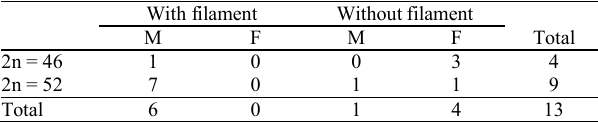
Table 3. Frequency of Pimelodella individuals with or without dorsal fin filament in relation to the diploid number and gender (M = male; F =